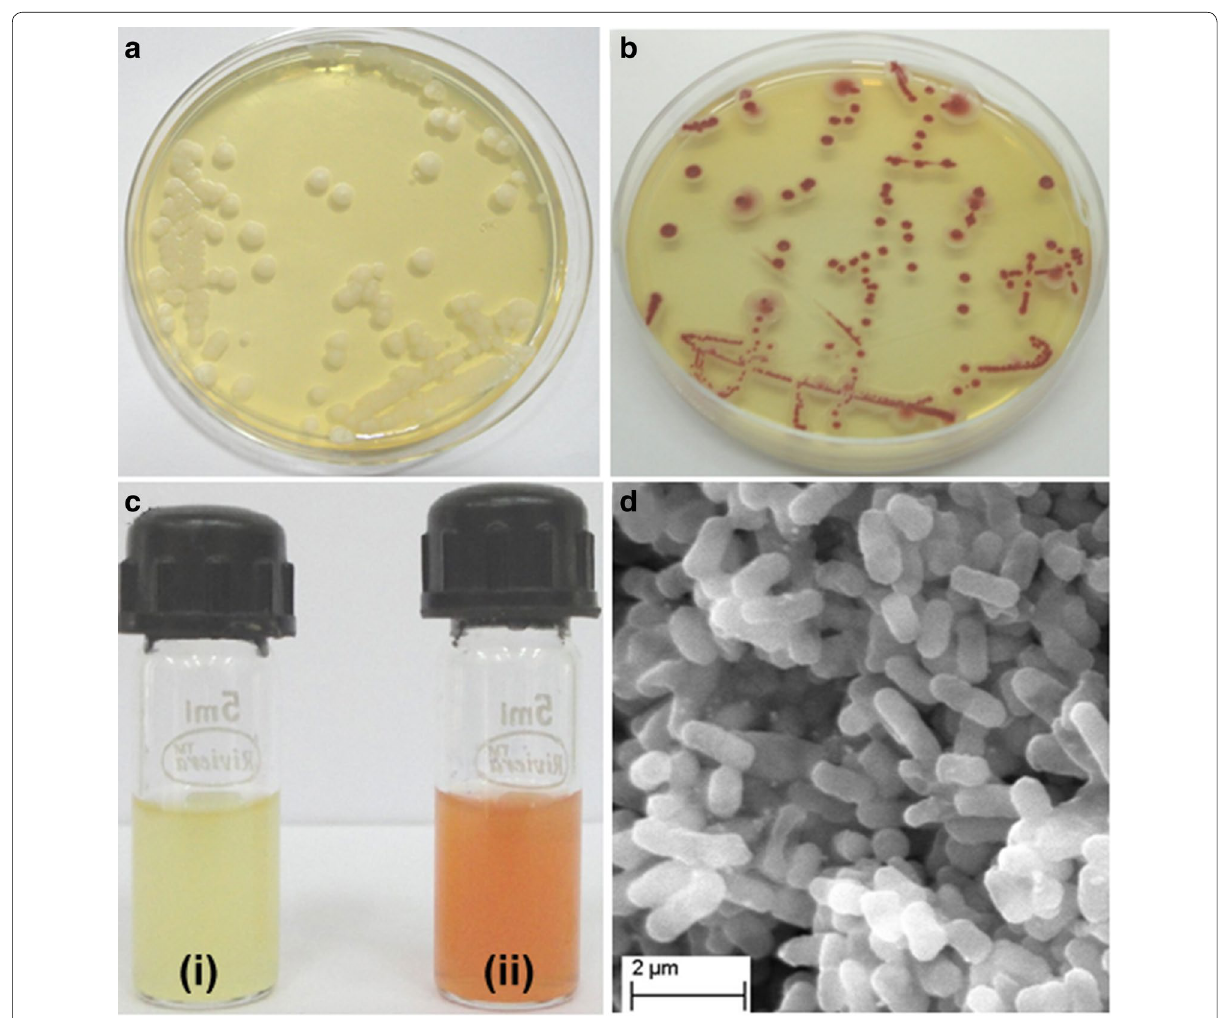
Fig. 1 Bacterial culture plates showing single colonies of AJK3 strain on a nutrient agar and b nutrient agar supplemented with 1 mM selenite. c Colour of the bacterial culture broth (i) without and (ii) with selenite supplementation and d SEM image of bacterial